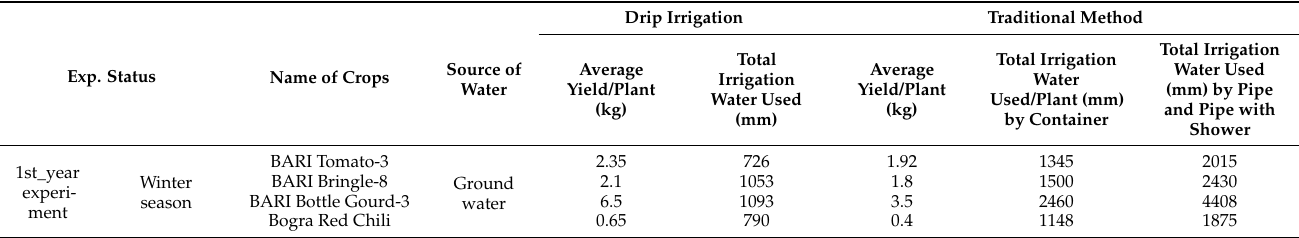
Table 7. Average yield and irrigation water requirements of BARI Tomato-3, BARI Bottlegourd-3, BARI Brinjal-8 and Bogra Red